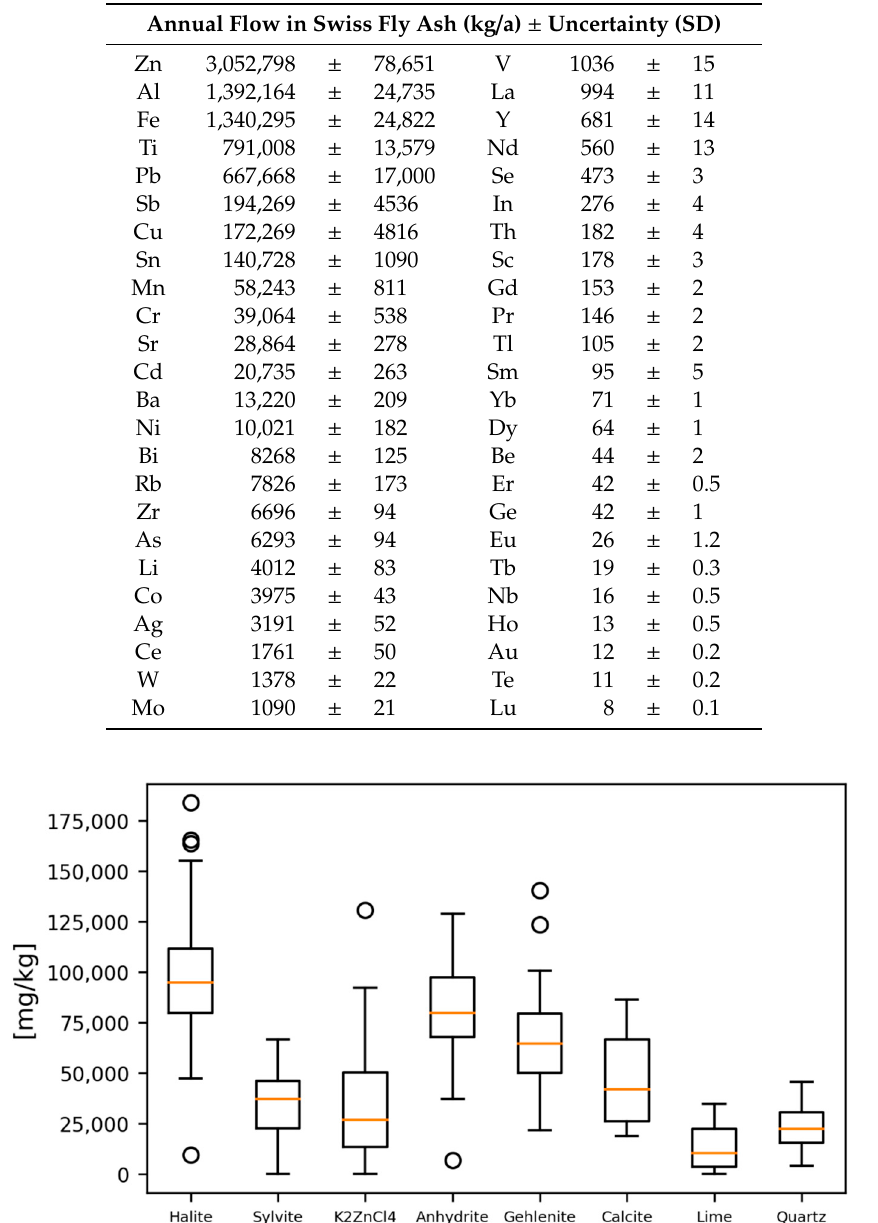
Figure 2. Distribution of the main mineral phases in Swiss FA in wt.%. Outliners are marked as circle. Table 3. Approximate annual flow of metals in Swiss FA.